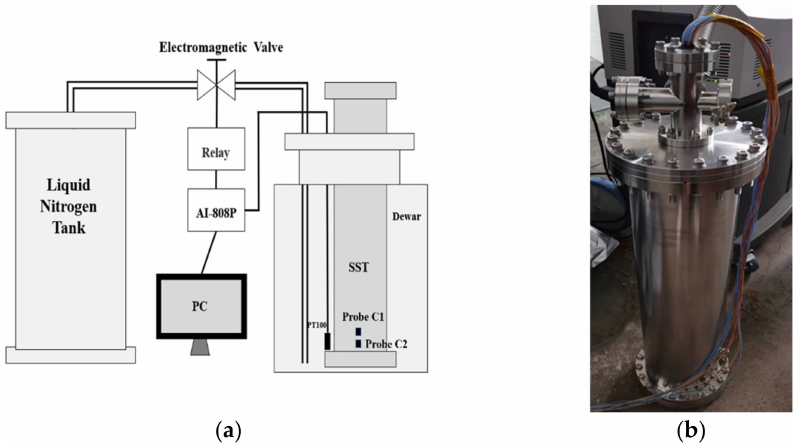
Figure 1. ( a ) Scheme of the cryogenic system; ( b ) photo of the stainless-steel chamber.